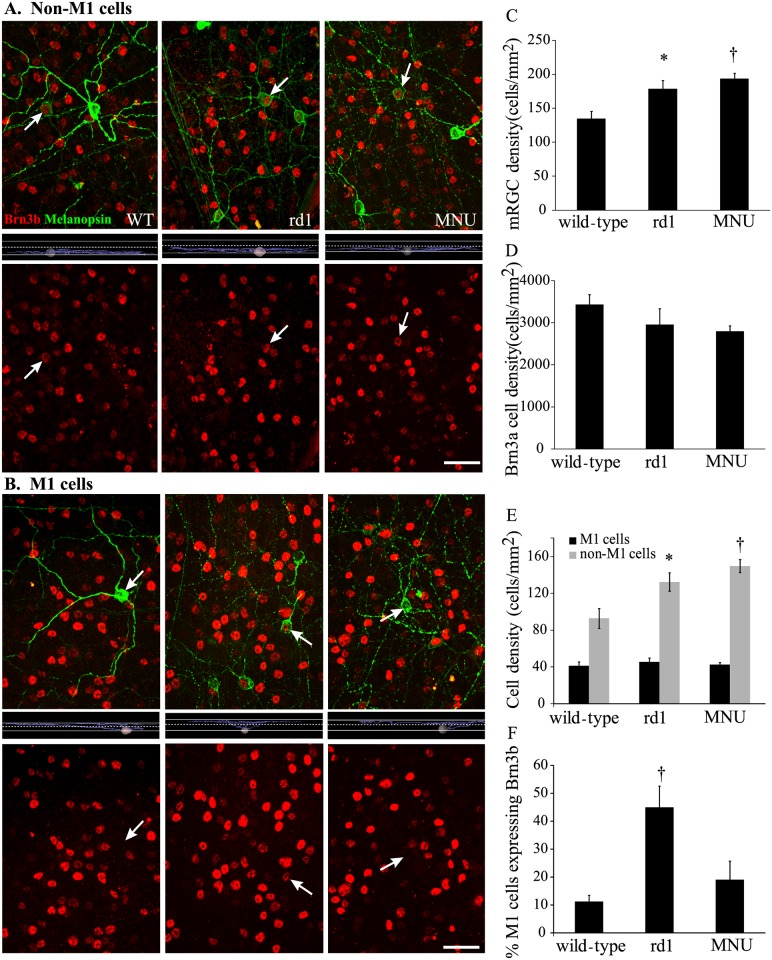
Both rd1 and MNU-injected mice had higher numbers of mRGCs, but only rd1 mice had a higher proportion of Brn3b-expressing M1 cells than in wild-type.A) Representative images from flatmounted retinas double-labeled for melanopsin (green) and Brn3b (red), showing non-M1 cells (arrows) in wild-type (WT, left), rd1 (middle) and MNU (7 days post injection; right). Top row shows original images, middle row shows dendritic stratification of the marked non-M1 (arrow) cells, and bottom row shows the same images with melanopsin signal digitally removed to more clearly show the Brn3b labeling in the non-M1 cells. The middle images show 2 thin solid lines marking the boundaries of the IPL and a thin dashed line separating the Off (top) and On (bottom) sublaminas in the IPL. The faintly-labeled non-M1 cells (arrows) stratified in ON sublamina and expressed Brn3b in wild-type, rd1 and MNU-injected mice. Scale bar: 50 μm. B) Representative images from flatmounted retinas double-labeled for melanopsin (green) and Brn3b (red), showing M1 cells (arrows) in wild-type (left), rd1 (middle) and MNU (7 days post injection; right). Top row shows original images, middle row shows dendritic stratification of the marked M1 (arrow) cells, and bottom row shows the same images with melanopsin signal digitally removed to more clearly show the Brn3b labeling in the M1 cells. The middle images show 2 thin solid lines marking the boundaries of the IPL and a thin dashed line separating the Off (top) and On (bottom) sublaminas in the IPL. The brightly-labeled M1 cells (arrows) stratified in OFF sublamina and expressed Brn3b in rd1, but not in wild-type or MNU-injected mice. Scale bar: 50 μm. C) The density of mRGCs (mean ± SE) in wild-type, rd1 and MNU-injected mice. A one-way ANOVA showed significant differences among the 3 groups (F2,33 = 8.18; P = 0.001; n = 8 mice for wild-type and rd1, n = 20 for MNU-injected). A post hoc Holm-Sidak test revealed that both rd1 and MNU-injected mice had significantly higher numbers of mRGCs than wild-type. *P <0.05; †P <0.001. D) The numbers of non-mRGCs, identified by presence of Brn3a immunoreactivity, in wild-type, rd1, and MNU-injected mice were statistically similar (F2,5 = 1.16; P = 0.39; one-way ANOVA; n = 3 mice for wild-type and rd1, n = 2 for MNU-injected). E) Densities of M1 type of mRGCs in wild-type, rd1 and MNU-injected mice were similar (F2,33 = 0.32, P = 0.73; one-way ANOVA), whereas the densities of non-M1 cells were different (F2,33 = 9.74, P <0.001). A post hoc Holm-Sidak test showed that both rd1 and MNU-injected mice had significantly higher numbers of non-M1 cells than in wild-type (n = 8 mice for wild-type and rd1, n = 20 for MNU-injected). The MNU-injected group included animals in which mRGCs were counted at 3, 7, 14 or 28 days after the MNU injection (n = 5 mice each); data from all samples were pooled, because there was no statistical difference among the subgroups (data not shown). *P <0.05, †P <0.001. F) There was a significant difference in the proportion of M1 cells that expressed Brn3b among wild-type, rd1 and MNU-injected mice (F2,32 = 13.39, P <0.001, one-way ANOVA; n = 8 mice for wild-type, 7 for rd1, 20 for MNU). A post hoc Holm-Sidak test showed that the numbers in rd1 mice, but not in MNU-injected mice, were significantly higher than in wild-type. †P <0.001.